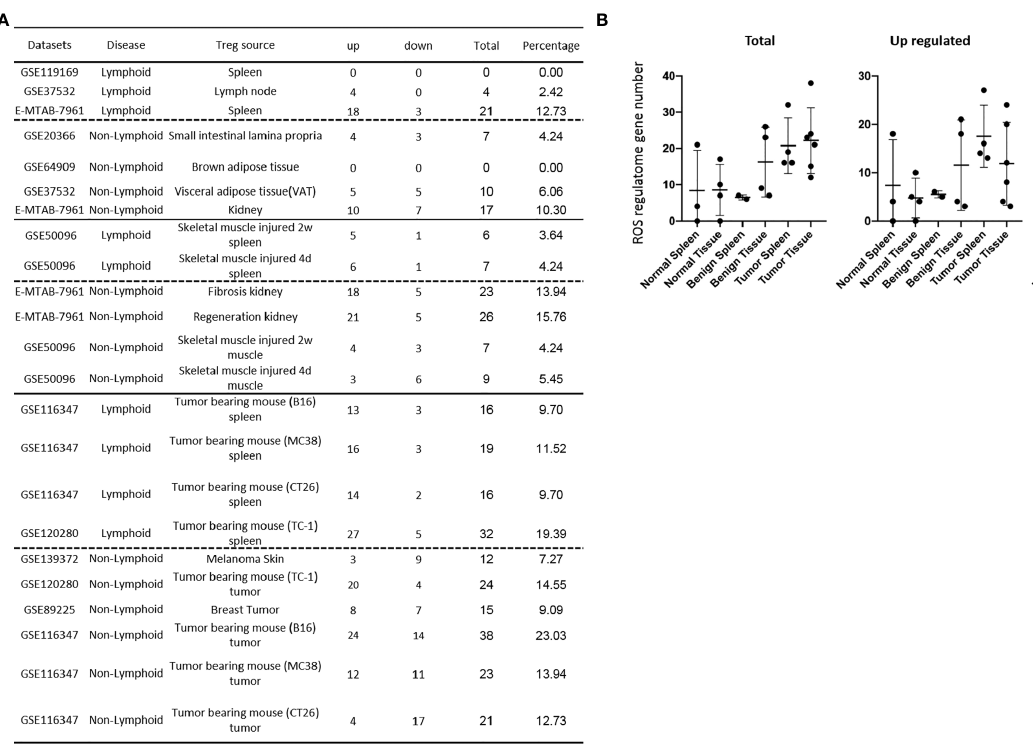
FIGURE 11 | (A) Reactive oxygen species (ROS) regulatome DEGs in tumor tissue Treg groups were more than that in the normal tissue Treg and benign diseased tissue Treg groups. A total of 165 ROS regulatome genes ( Supplementary Table 5 ) were screened in all the Treg groups. The upregulated ROS regulatome genes in tumor spleen Treg groups were more than that in the normal tissue Treg and benign diseased tissue Treg groups. However, the differences were not statistically signi fi cant. The downregulated ROS regulatome gene numbers were more in tumor tissue Treg groups than in other Treg groups (B) The differentially expressed ROS regultome genes in tumor tissue Treg groups were more than other Treg groups. The total regulated ROS regulatome gene numbers were more in tumor tissue Treg groups than that in normal tissue Treg groups, p = 0.16. The upregulated ROS regulatome gene numbers had no statistical differences between Treg groups. The downregulated ROS regulatome gene numbers were statistically more than other Treg groups, p <